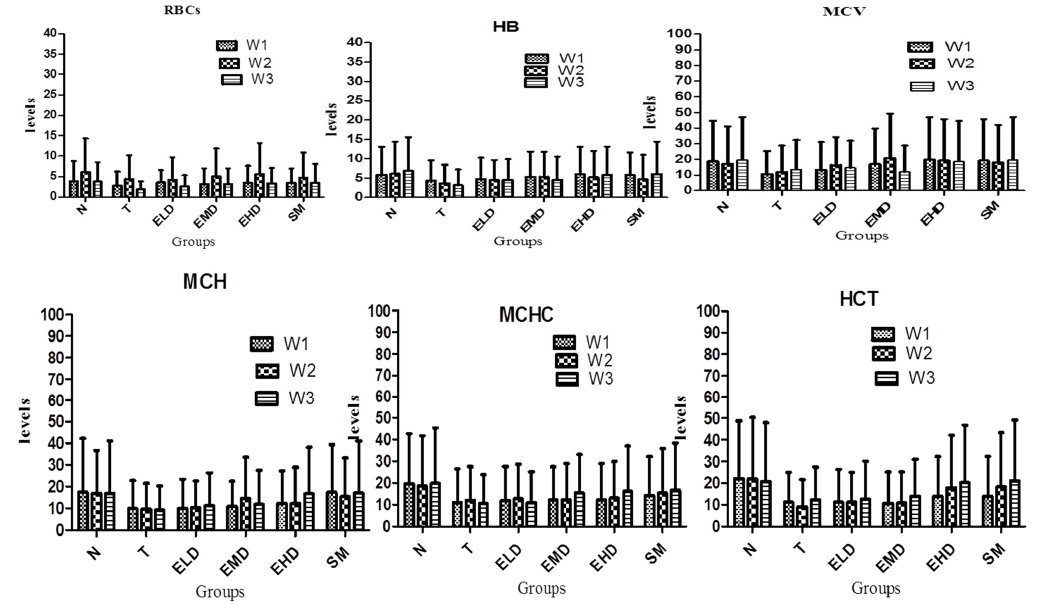
Figure 1. Graphical representation of hematological indices at week 1, week 2 and week 3 of differ ‐ ent experimental groups (Table 1).